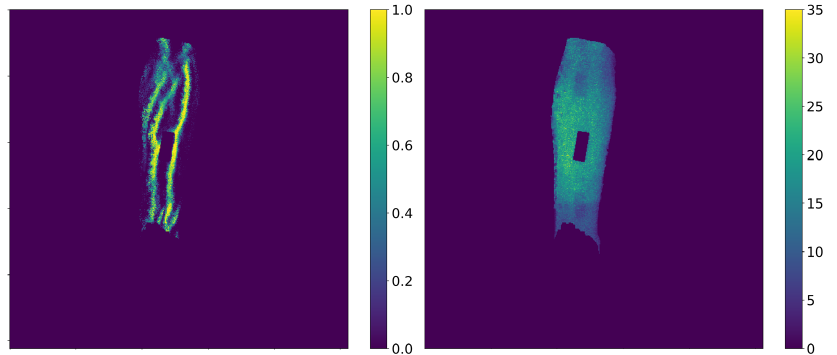
Figure 6. Reprojections from point cloud, accumulated across the whole session, back onto each frame. ( Left ) Density map D shows the reprojected vein prediction value, averaged over vein predictions made from different distances and angles across the whole session; ( right ) Sample count map C shows the number frames across the whole session where each point on the arm was visible and sampled from. Note the brighter middle portion, which was in view for most of the recording, and the darker rectangles, which were locations where the marker was placed, blocking the view of the underlying skin for different parts of the recording.